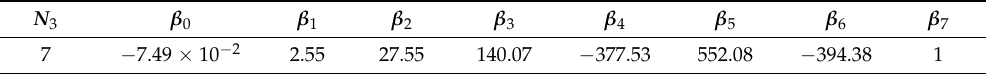
Table 2. Mean values of the polynomial parameters for f 3 ( d